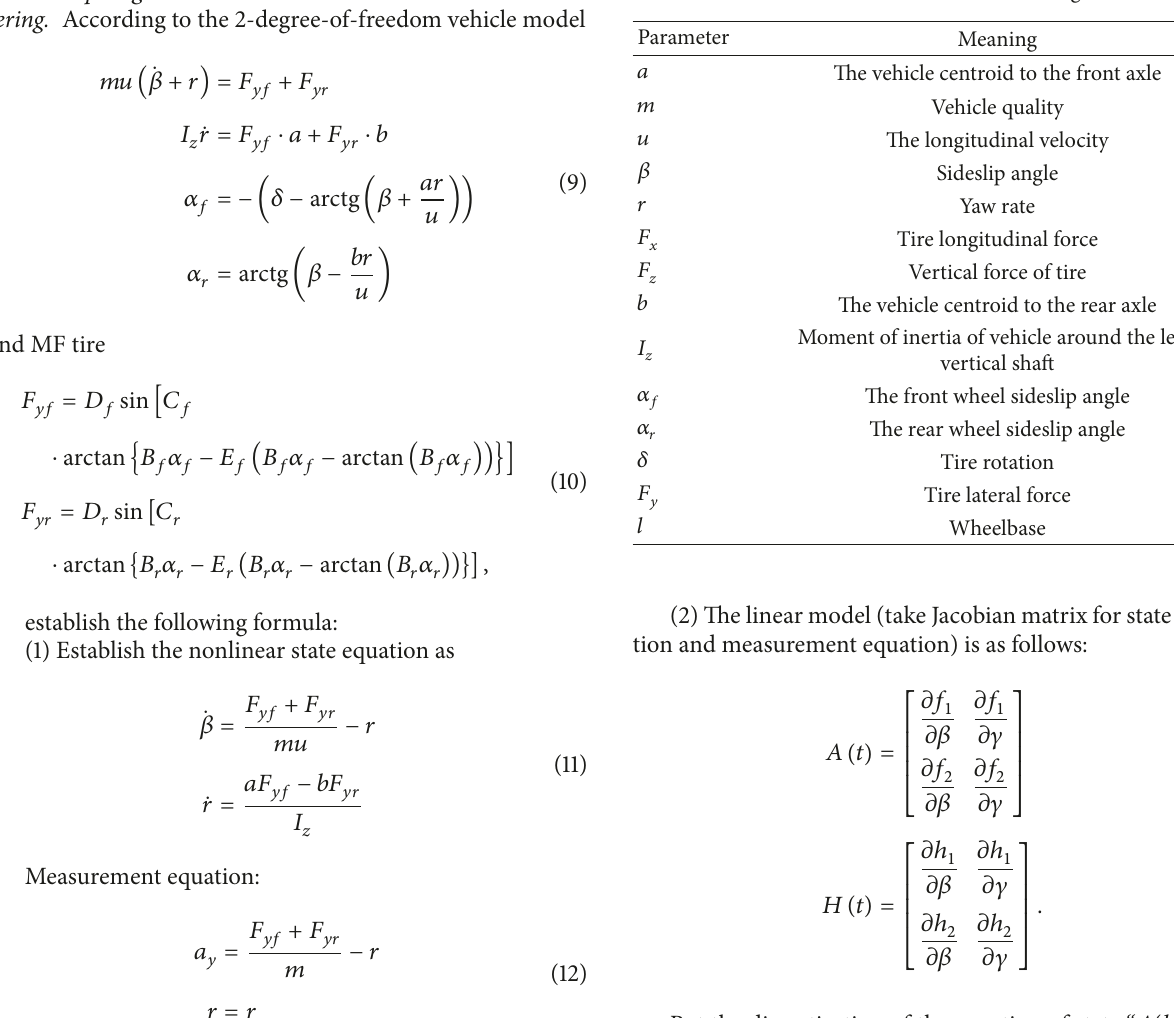
Table 1: Parameters and